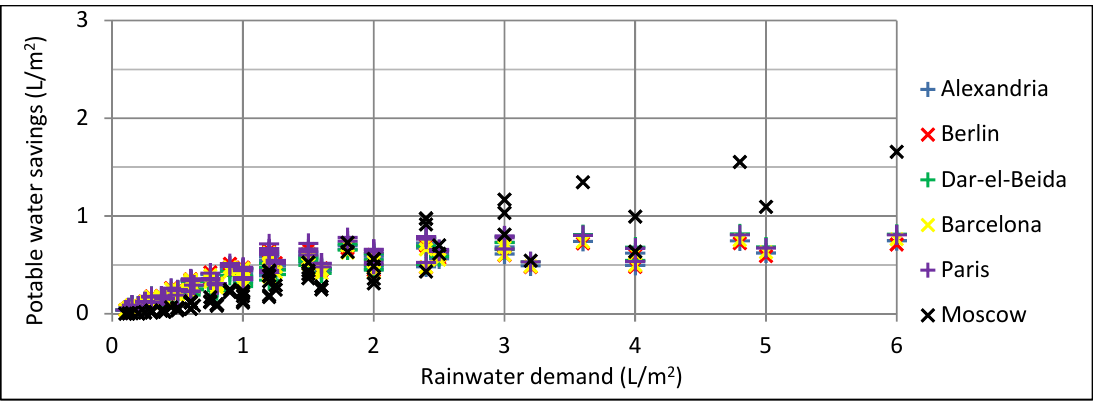
Figure 17. Correlation between potable water savings per catchment area and rainwater demand per catchment area for cities with annual rainfall up to 700 mm/year.